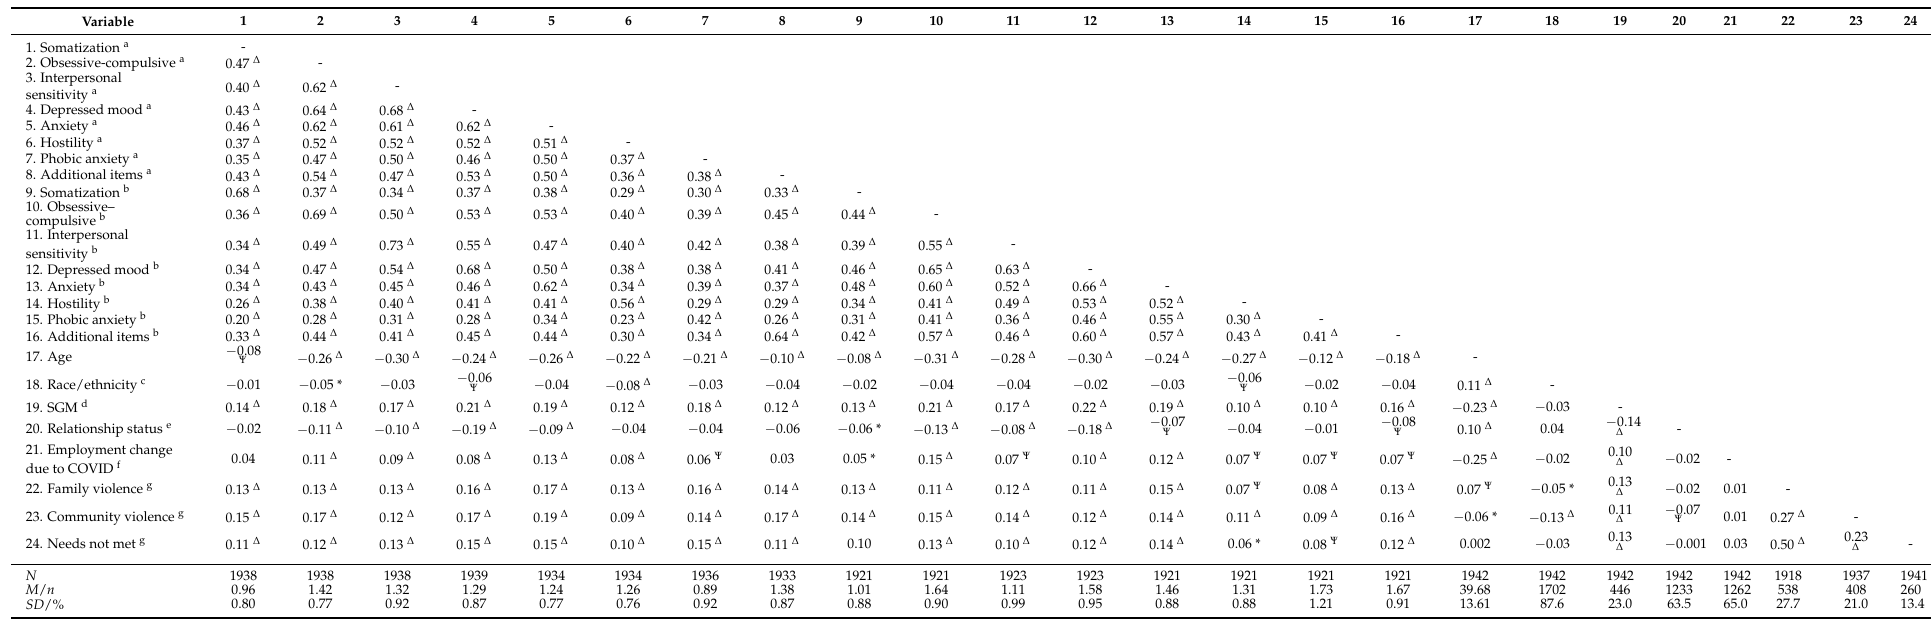
a Pre-COVID. b Post-COVID. c 0 = non-White racial identity and/or Latino/a/e ethnicity, 1 = White/White ethnic and non-Latino/a/e; frequency and percentage reflect those who identified as White/White ethnic and non-Latino/a/e. d 0 = cisgender and/or heterosexual, 1 = sexual and/or gender minority (SGM); frequency and percentage reflect those who endorsed a SGM identity. e 0 = not in a relationship, 1 = in a relationship; frequency and percentage reflect those who are in a relationship. f 0 = no change; 1 = working from home, laid off/fired, or started a new job; frequency and percentage reflect those whose employment changed due to COVID. g 0 = not endorsed, 1 = endorsed; frequency and percentage reflect those who endorsed exposure to childhood adversity. * p < 0.05. Ψ p < 0.01. ∆ p <